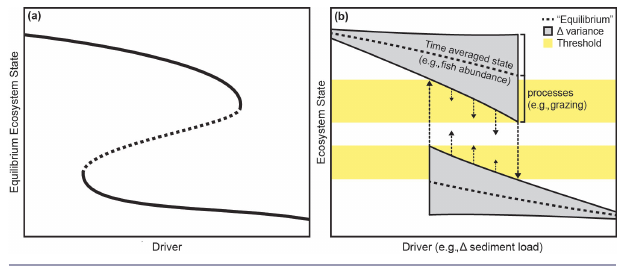
Fig. 4 . (a) The standard representation of critical transitions in ecosystem states may lead to some confusion because the equilibrium ecosystem state is represented as a stable line (while the dashed line passes across an area where ecosystem transitions can occur). (b) “Equilibrium” states (dashed lines), however, may simply represent a time averaged artefact of our inability to monitor variability in processes in real time. For example, monitoring fish abundance or coral cover may have little relevance to the functions being performed by the groups and the resilience of the ecosystem being observed. Using more sensitive metrics, such as process-based monitoring, e.g., grazing rates, may provide instantaneous estimates of ecosystem state and allow detection of changes in the nature of this variance, e.g., increasing amplitude, skewness, or autocorrelation. In turn these changes ( Δ variance) may allow predictions of critical transitions through highlighting subtle shifts in function or through predictive models (cf. Dakos et al. 2008, Guttal and Jayaprakash 2008, Scheffer et al. 2009, Benedetti-Cecchi et al. 2015). Ecosystem transitions (arrows) are increasingly likely when fluctuations reach threshold states (horizontal yellow bars). Whether Pioneer Bay is at, or beyond a threshold state, is likely to depend upon the stability of the current benthic sediment loads. (a) redrawn from (Scheffer et al.